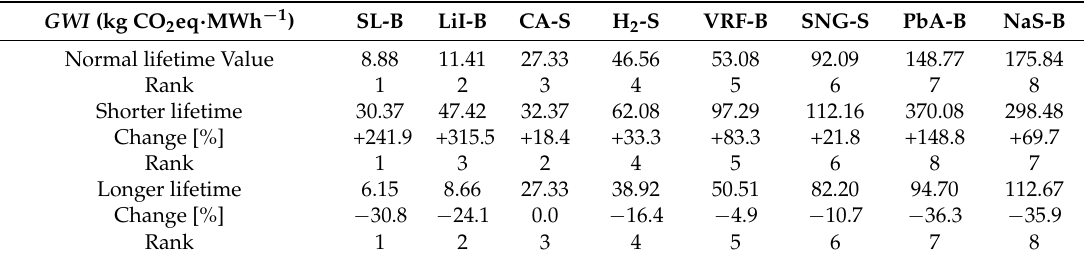
Table A1. Ranking of electrical energy storage technologies for GWI with normal, shorter and longer lifetime.